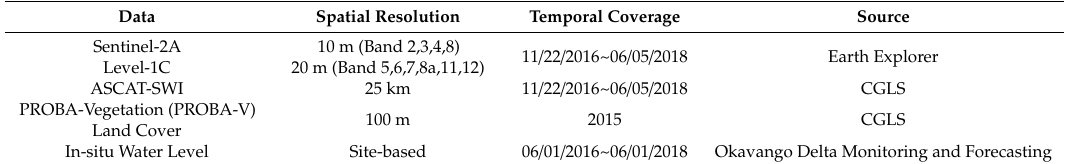
Table 1. Overview of primary and ancillary datasets used in the